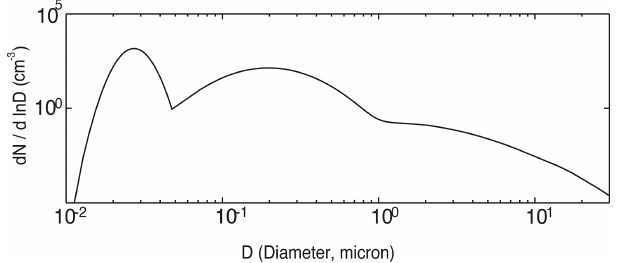
Figure 4. Aerosol size distribution at the surface. N represents aerosol number concentration per unit volume of air, and D rep- resents aerosol